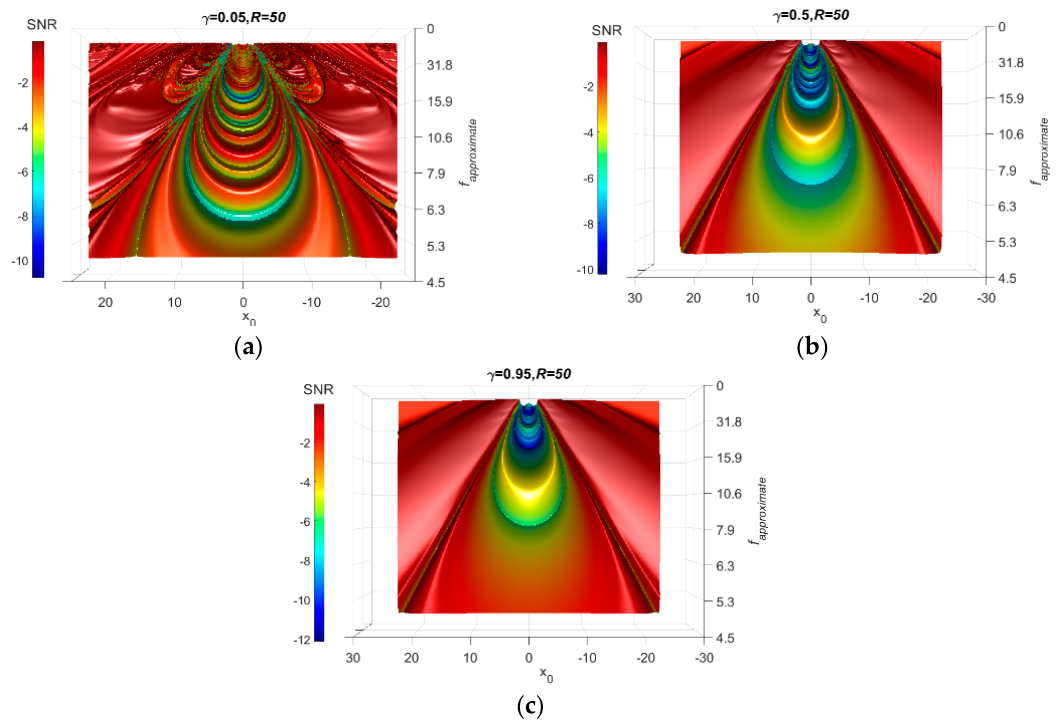
Figure 6. FI-UPSR results ( a ) SNR surface plot, ( b ) extracted weak signal, and ( c ) PSD plot for the extracted signal.